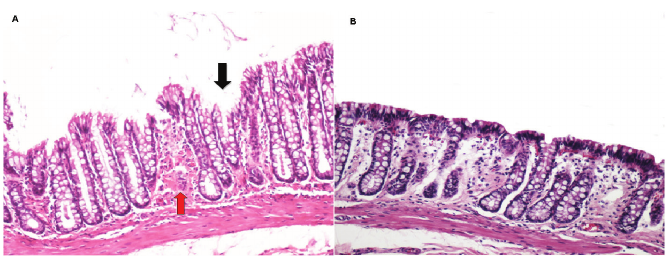
FIGURE 2 – A. Segment of the colon without fecal stream irrigated with saline for 4 weeks showing epithelial ulcers (black arrow) and mucosal edema (red arrow). B. Segment of the colon without fecal stream irrigated